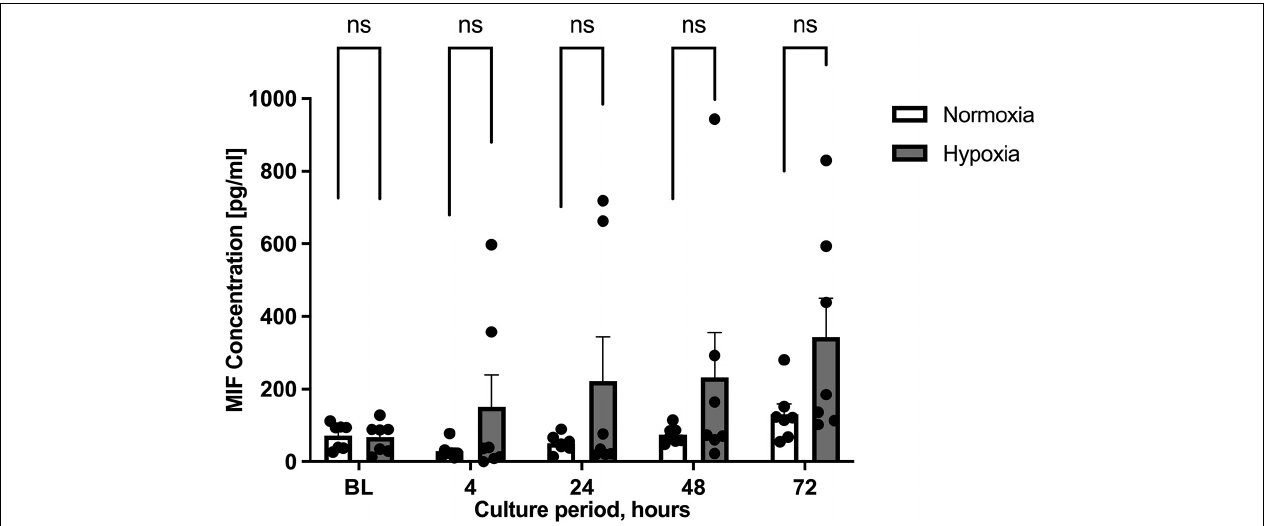
FIGURE 2 | Migration inhibitory factor (MIF) secretion levels under normoxic and hypoxic conditions. Cells were cultured in starvation medium at normoxic oxygen levels of 21% O 2 or hypoxic oxygen levels of < 1% O 2 . Supernatants of ASCs were collected at indicated measuring points and ELISA was performed to determine MIF secretion by ASCs under normoxic and hypoxic conditions. Baseline levels (BL) were obtained at the starting point 0 h. The graph displays pooled results from patients group A (healthy donor sites) and group B (chronic non-healing wounds). Analyses were performed for seven biological replicates ( n = 7). Data are mean values ± SEM (two-way ANOVA, Holm-Šídák’s multiple comparisons test, not significant).